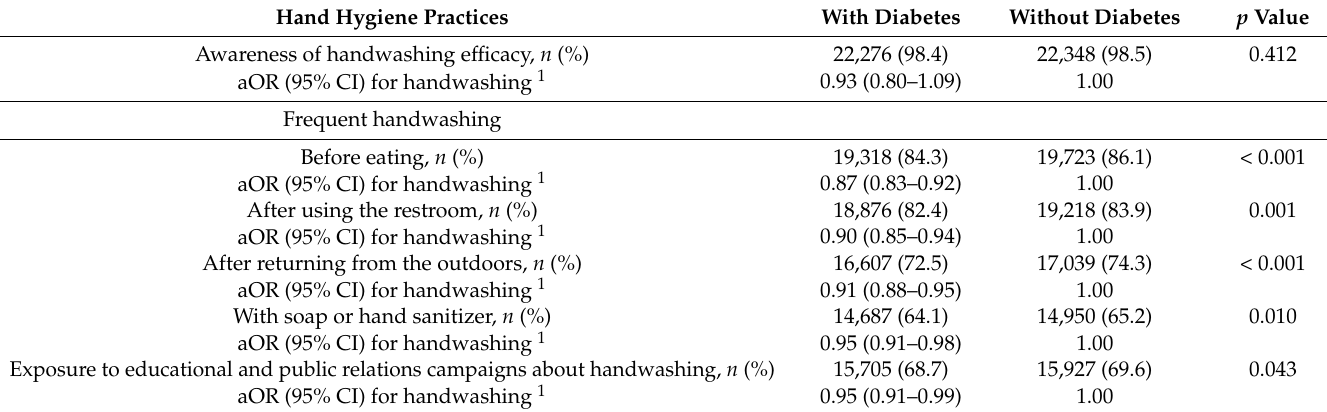
Table 2. Hand hygiene practices among people with and without diabetes.